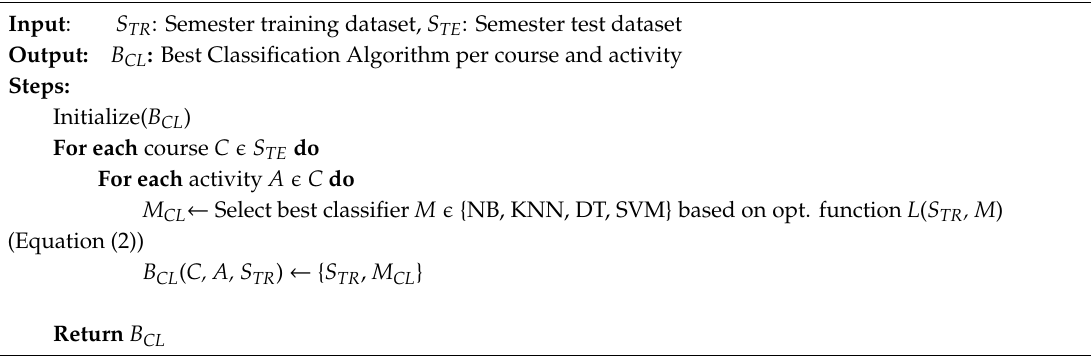
Algorithm 1. Pseudocode of